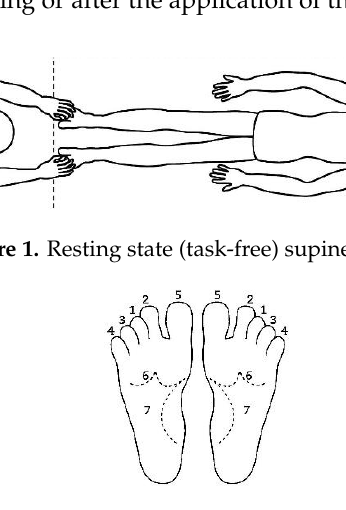
Figure 2. Sequential order of bilateral points of tactile contact.